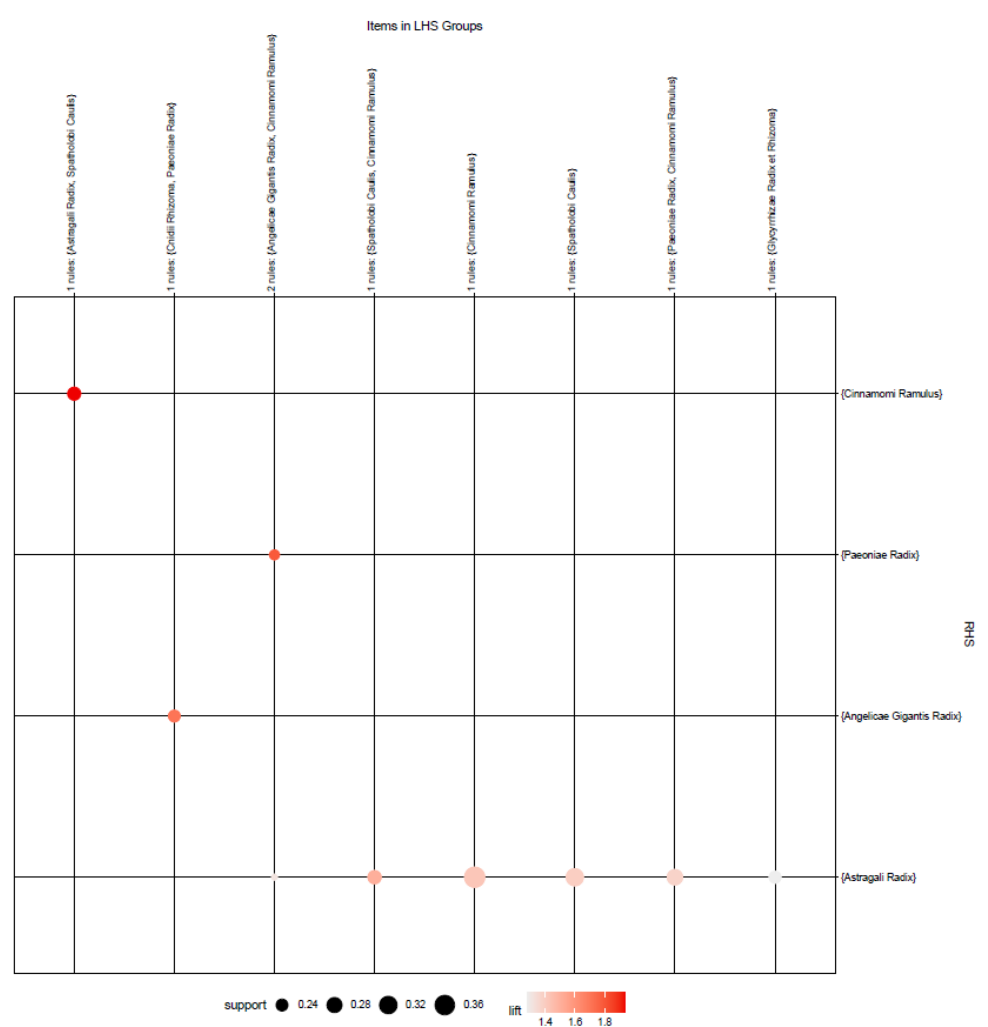
Figure 15. Grouping matrix of the association rules in the meta-analysis of East Asian herbal medicine prescribed for peripheral neuropathy.